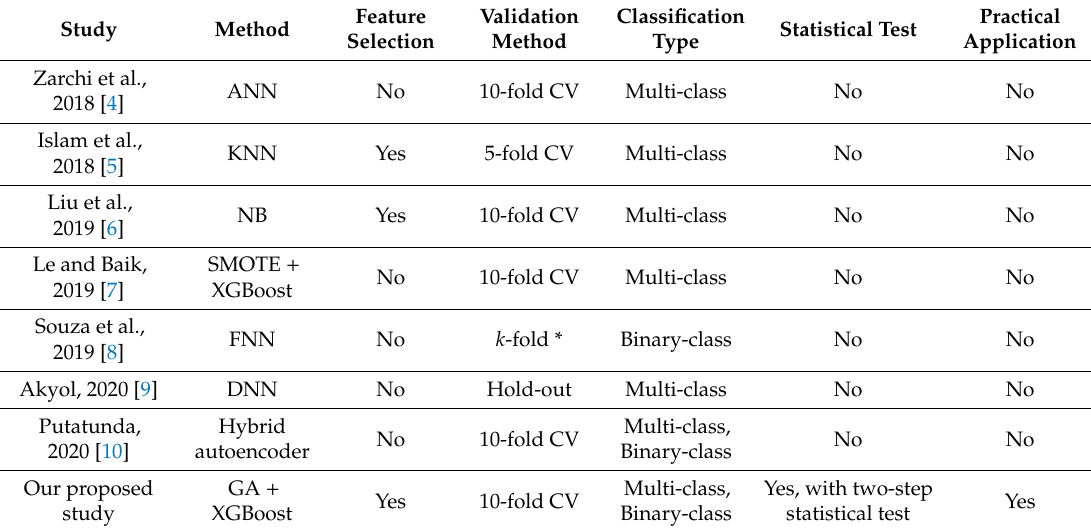
Table 1. Summary of existing works for self-care prediction of children with disabilities as compared to our proposed